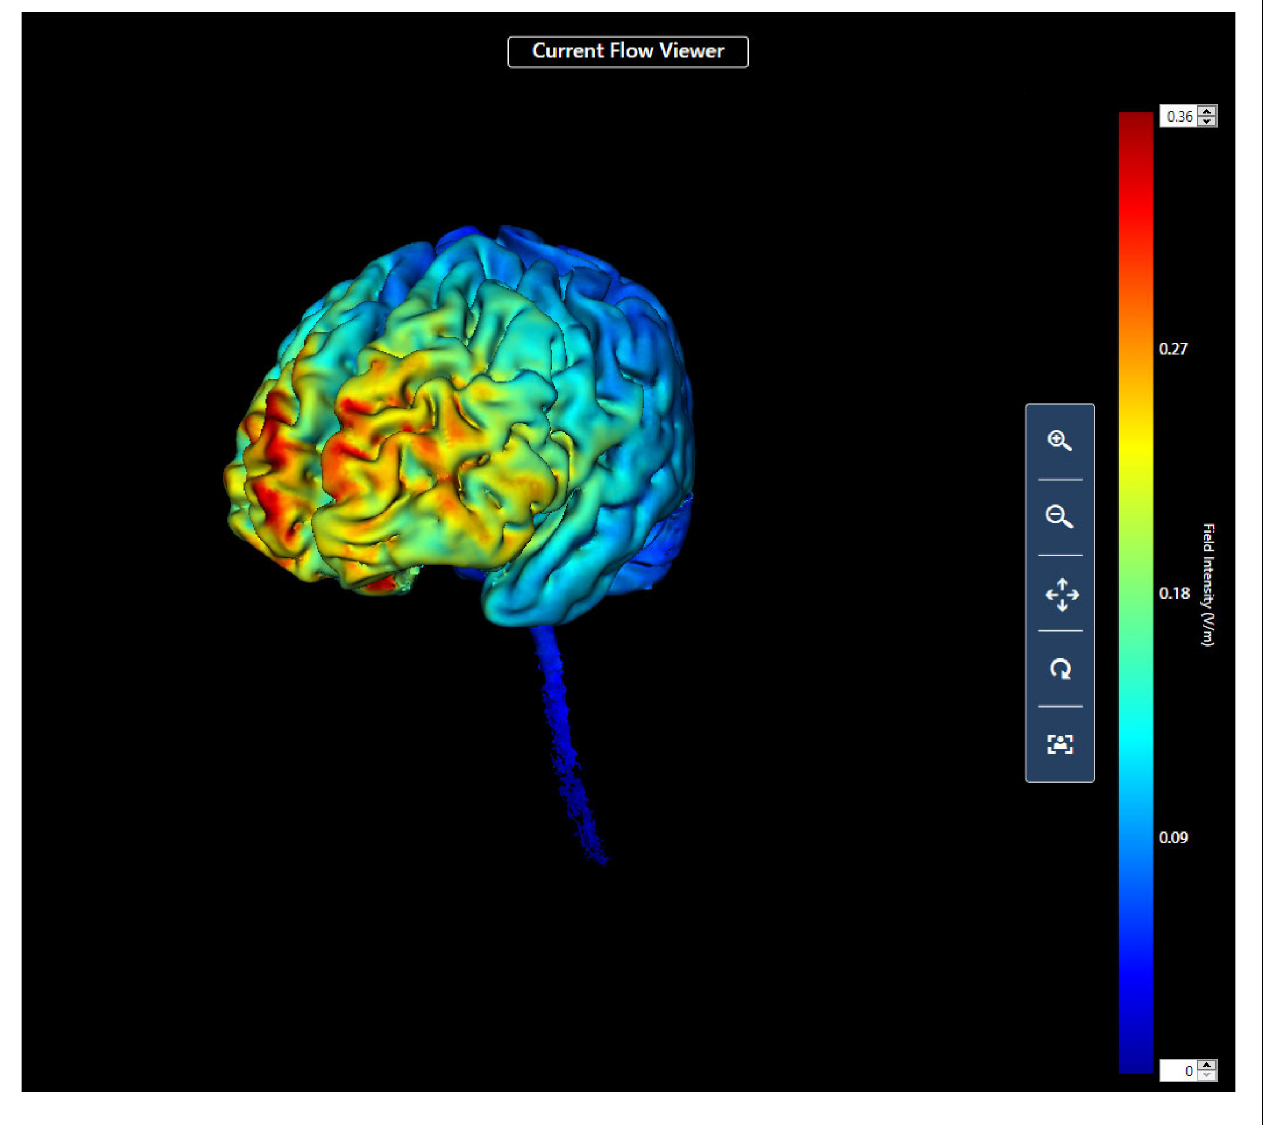
FIGURE 1 | Computer simulation of current